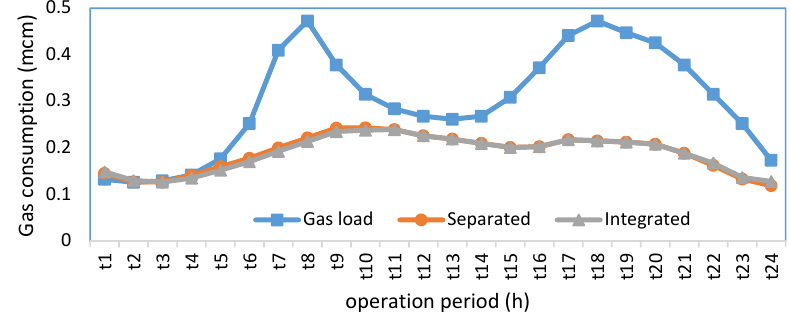
Table 4. Operation Cost of NGEN.